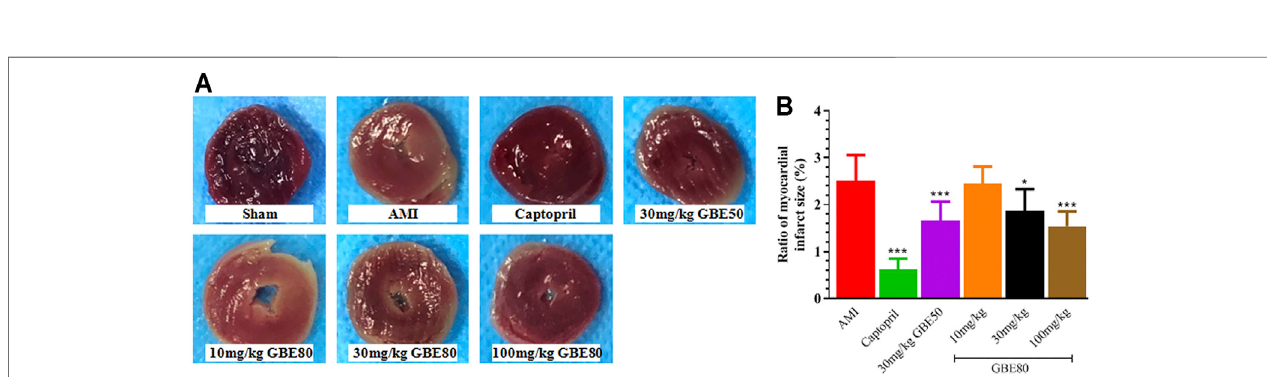
FIGURE 3 | GBE80 administration exerts bene fi cial effects on the size of the myocardial infarction. (A) Representative fi gures of the triphenyltetrazolium chloride (TTC)-stained myocardial tissues of acute myocardial infarction (AMI) rats receiving indicated treatment; and quantitative (B) statistical analysis of the myocardial infarct size. (*, *** indicates p < 0.05, p < 0.001 vs the AMI group, respectively).